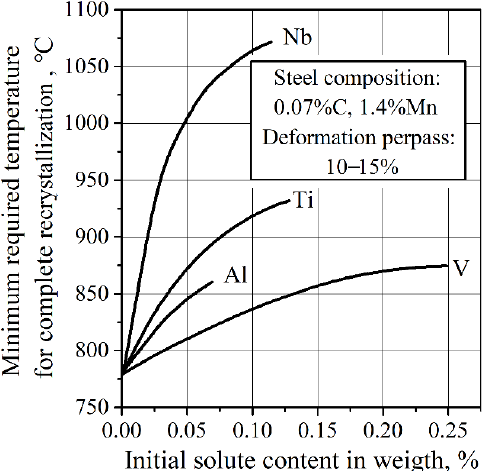
Figure 9. Effect of microalloying elements Nb, V, and Ti on austenite recrystallization stop tempera- ture [64,65]. This figure is reproduced based on